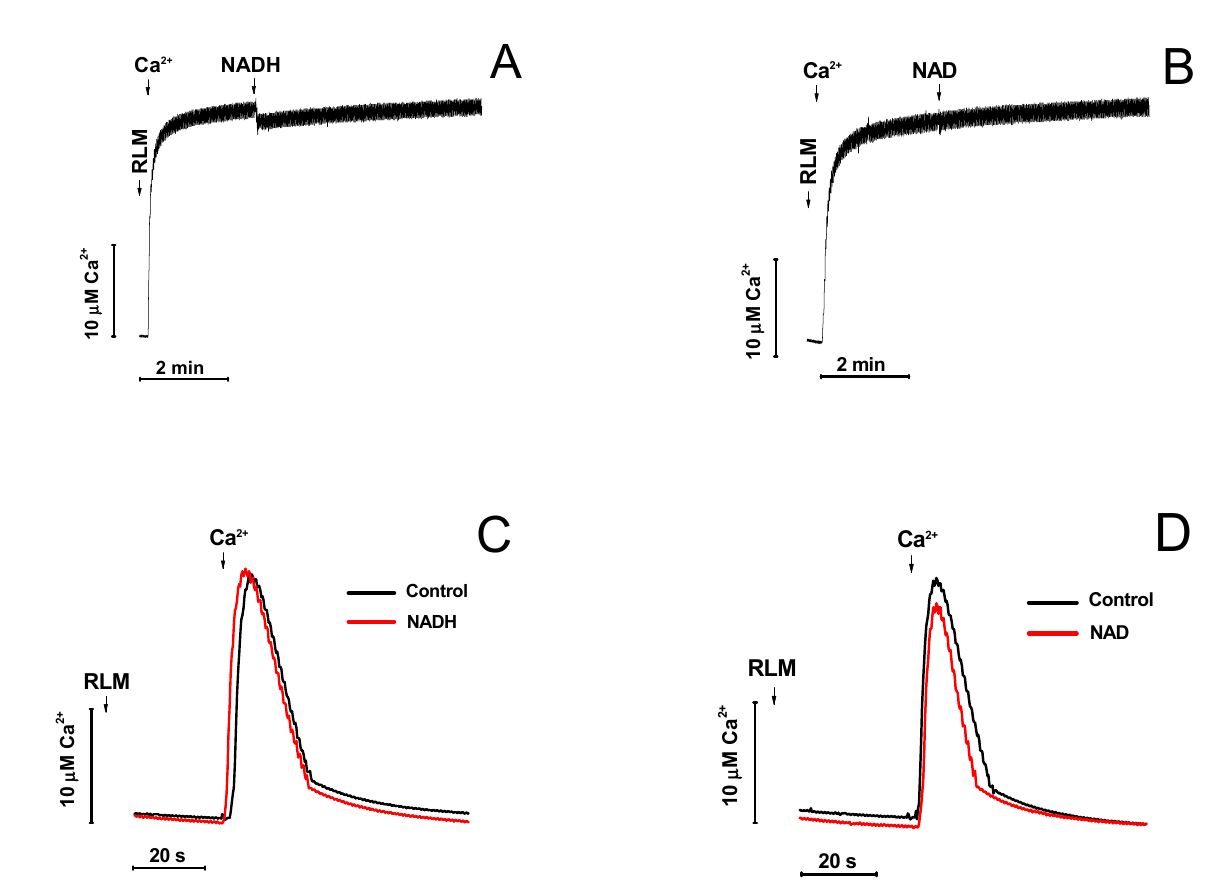
Figure 2. Effect of NADH and NAD + on the concentration of free Ca 2+ in the incubation medium ( A , B ) and the rate of Ca 2+ uptake by mitochondria ( C , D ). ( A , B ). KCl-BM without mitochondria was placed in a chamber equipped with a Ca 2+ -selective electrode. Arrows indicate the addition of 20 µ M Ca 2+ , 2 mM NADH ( A ), and 2 mM NAD + ( B ). ( C , D ). RLM (1 mg prot./mL) were placed in the KCl-BM supplemented, where indicated, with 1 mM NADH ( C ) or 1 mM NAD + ( D ). Two minutes later, 20 µ M Ca 2+ was added and its uptake was recorded. Representative curves of one experiment of at least three similar are shown.